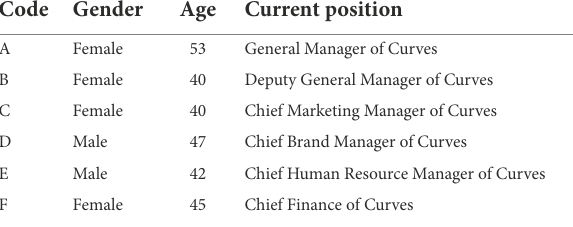
TABLE 1 Basic information of participants. Code